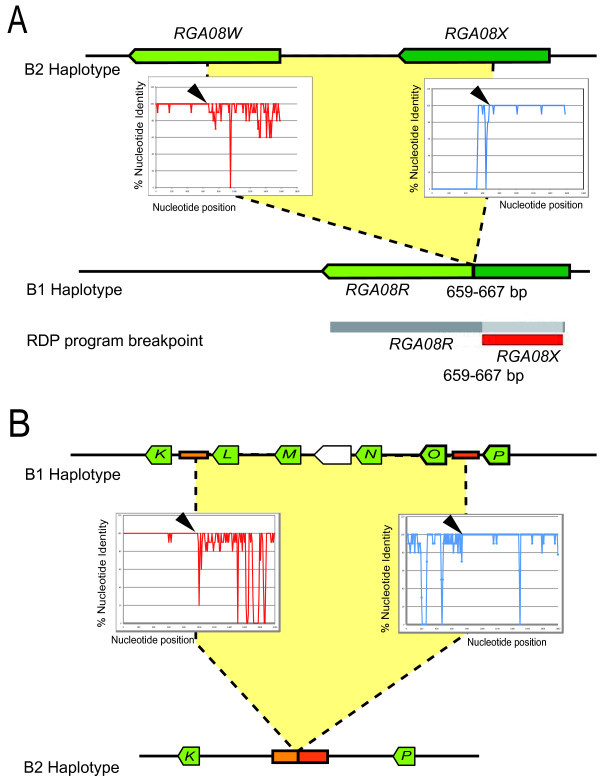
Unequal recombination breakpoints within the RGA08 gene cluster. (A) An intragenic unequal recombination event between RGA08X and RGA08W results in the actual structure of the RGA08R sequence. The RDP software detected the region of sequence identity between RGA08X and RGA08R and indicated a recombination breakpoint on RGA08X. Manual inspection of RGA08 sequence alignments indicated RGA08W and RGA08X as likely parental sequences. The percent nucleotide identity of RGA08X (red curve) and RGA08W (blue curve) is plotted along the sequence of RGA08R. A shift in sequence identity levels (black arrows) is observed indicating a putative recombination event. (B) Unequal recombination mediated by duplicated 1 kb intergenic sequences (orange boxes). Intergenic sequences between RGA08K - RGA08L and RGA08O-RGA08P in B1 (top) have recombined to produce the actual intergenic sequence structure between RGA08K - RGA08P in B2 (bottom). Percent of nucleotide identity between 1 kb intergenic sequences of B1 is plotted along the B2 sequence. High sequence identity is visible at the beginning of the RGA08K - RGA08L intergenic sequence (red curve) and at the end of the RGA08O-RGA08P intergenic sequence (blue curve). Black arrows indicate breakpoint position.